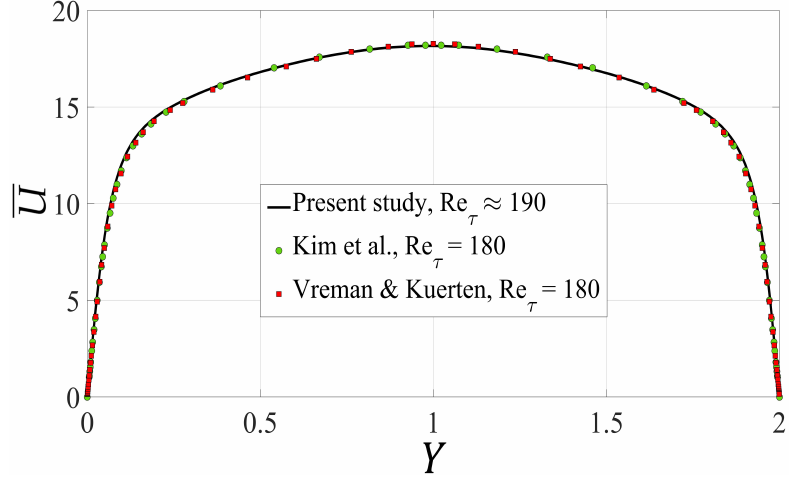
Figure 6. Mean velocity profile in global coordinates for the smooth channel case.